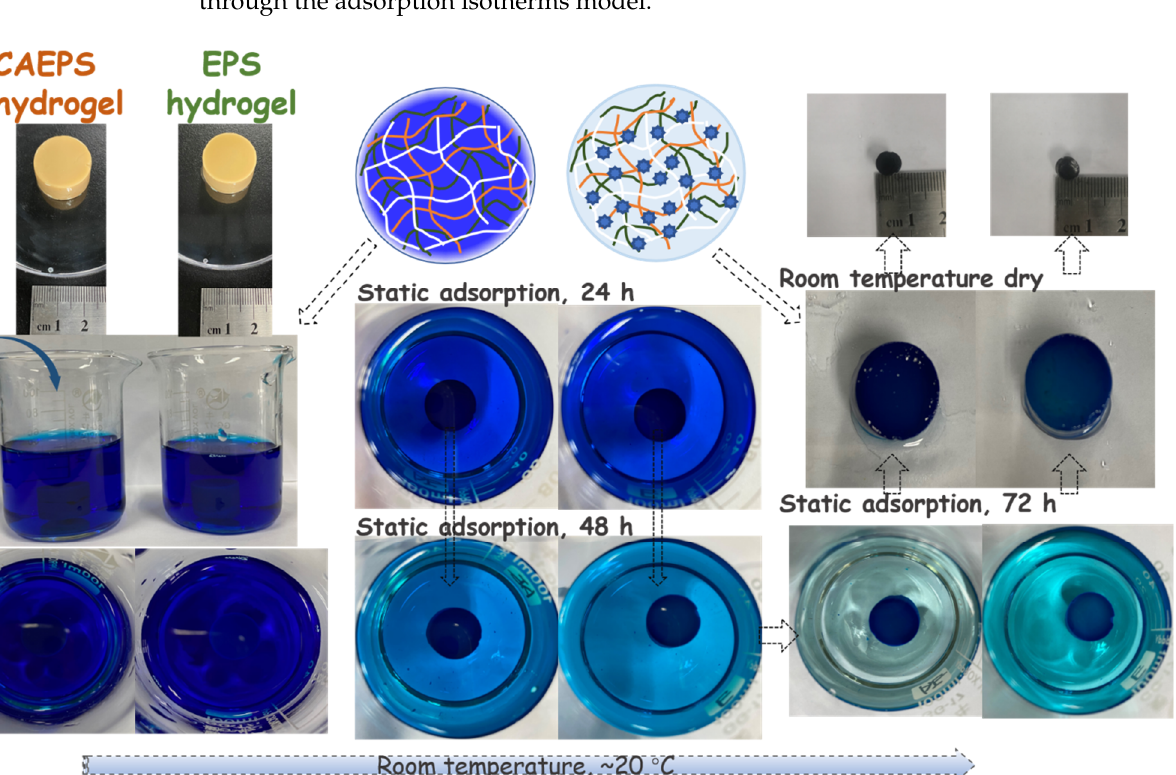
Figure 10. Effect of methylene blue, Cefuroxim, and Cr 2 O 72− concentration on the adsorption of EPS- and CAEPS-hydrogel and the isotherm model, respectively. Note: About 10 g of wet EPS- and CAEPS-hydrogel was added to the prepared 50 mL in different concentrations of MB solution for 72 h, Cefuroxime solution, and K 2 Cr 2 O 7 solution for 48 h until static adsorption equilibrium in room temperature (~20 °C) was reached, respectively.